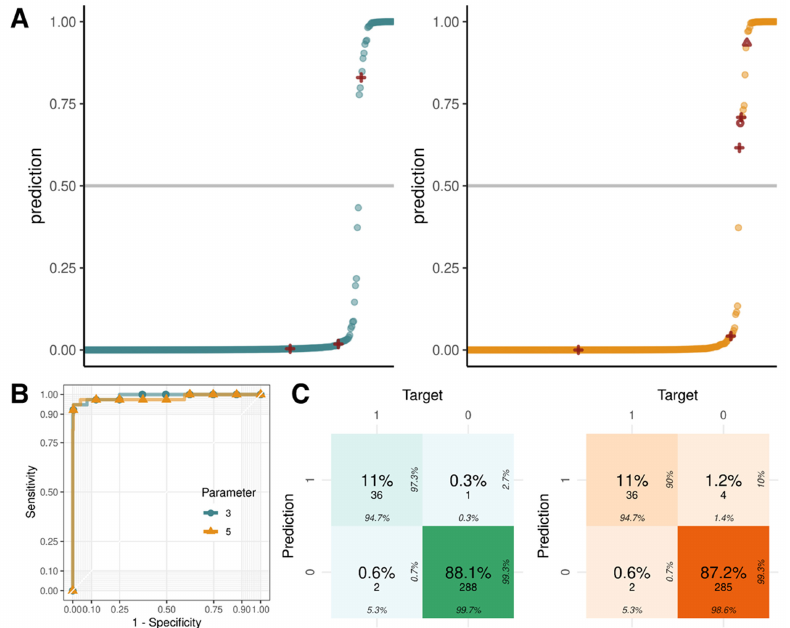
Figure 4. Logistic regression with the Z-scores, GC content (%), and FF (%) parameters of the three methods. ( A ) Logistic regression with three (STD, NCV, and WSRB) and five (STD, NCV, WSRB, GC, and FF) parameters. A point indicates the probability that a specific chromosome of a sample is a trisomy. A red mark represents incorrect prediction. ( B ) Receiver operating characteristic (ROC) curves of logistic regression with three and five parameters. ( C ) Confusion matrix of logistic regres- sion with three and five parameters. Graph colors are different according to the parameter number (three parameters: green, five parameters: orange).